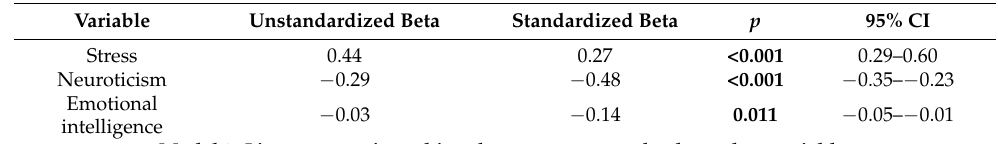
Model 2: Linear regression taking the anxiety score as the dependent